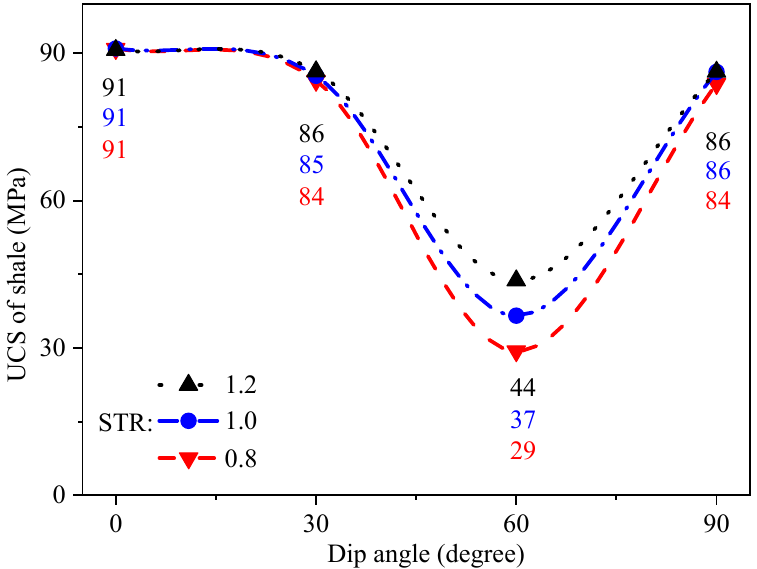
Figure 12. Variation of uniaxial compressive strength of shale at different STR.